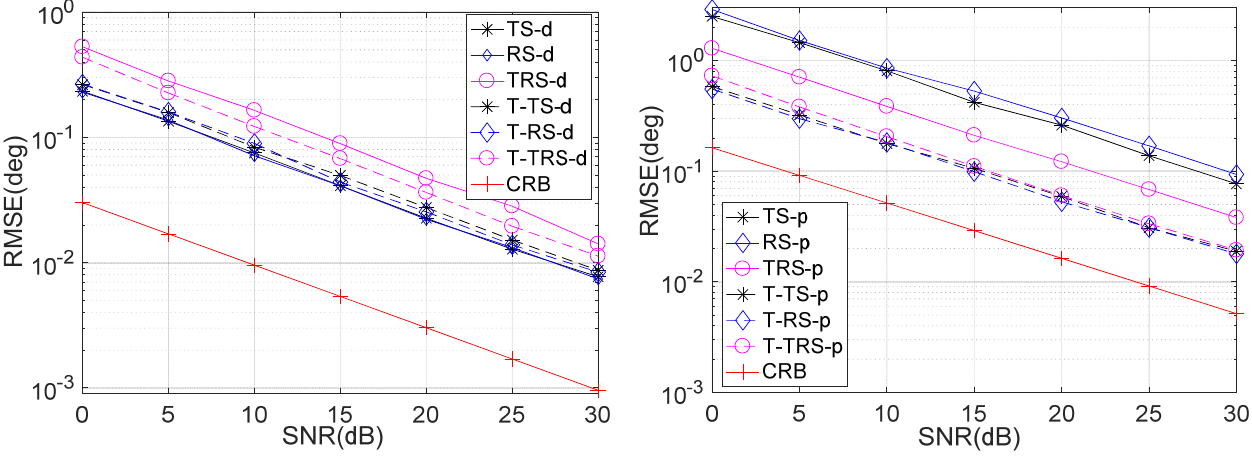
Figure 3. RMSE of parameter estimation versus SNR in Case (I).